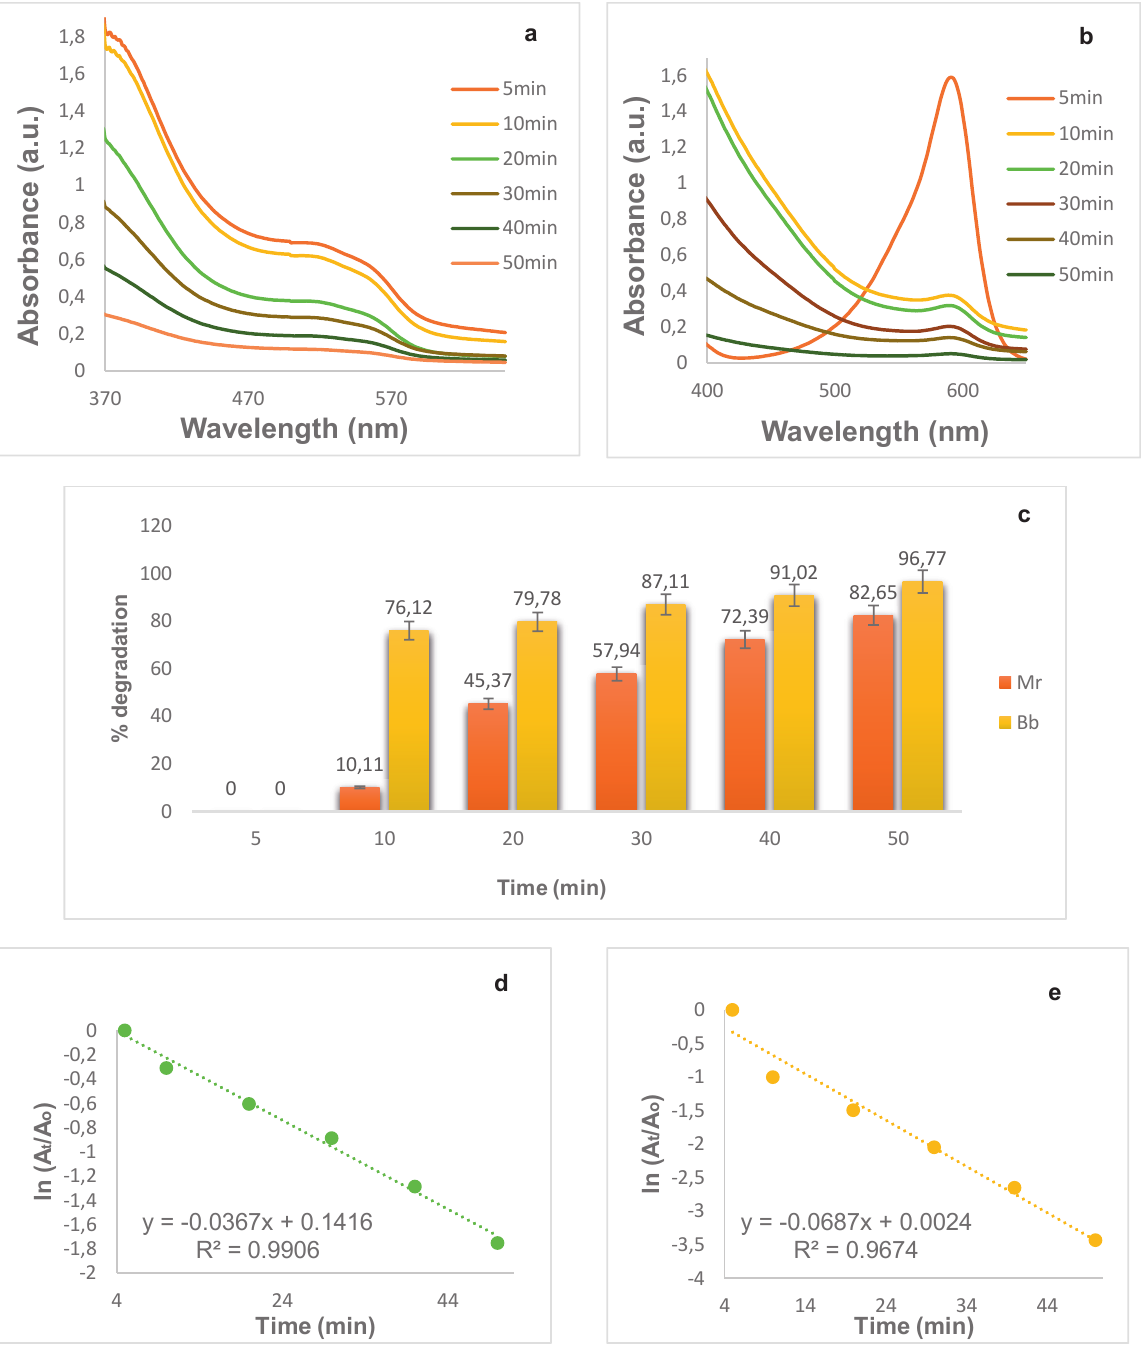
/A ) vs time plot of methyl red and bromophenol t o